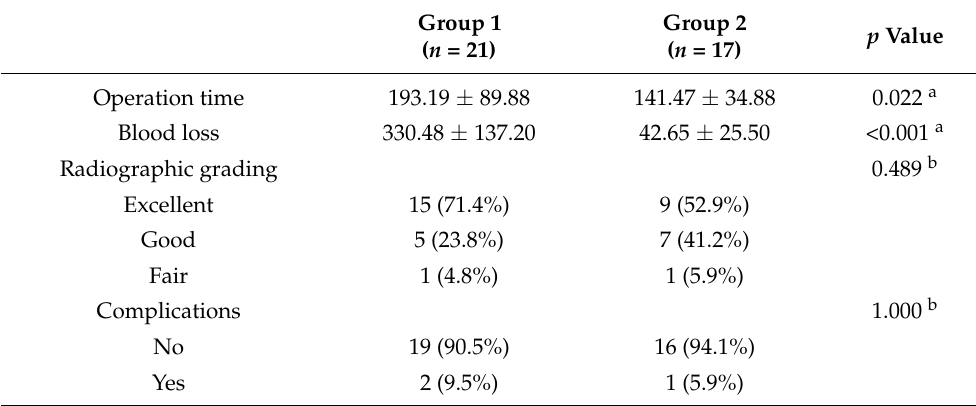
Table 2. Surgical outcome